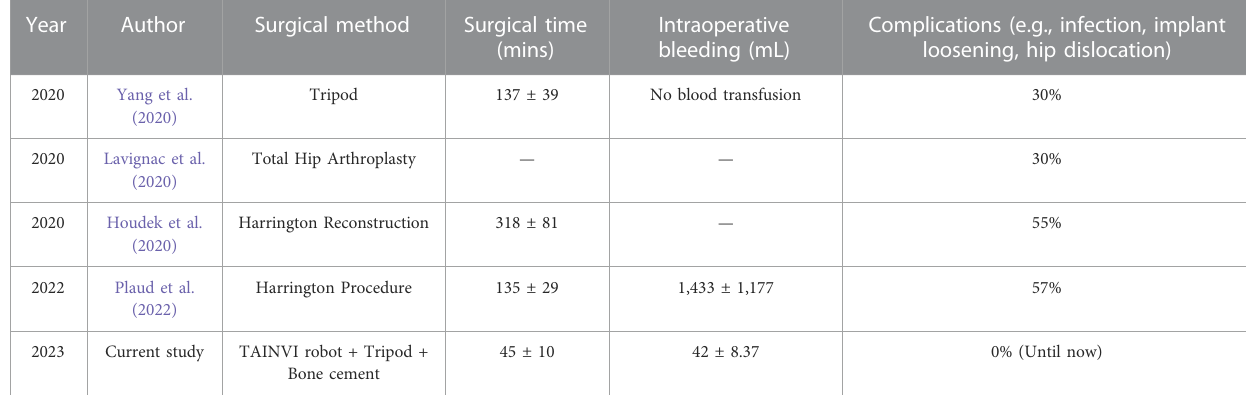
TABLE 3 The comparison of different surgical methods for acetabular metastatic